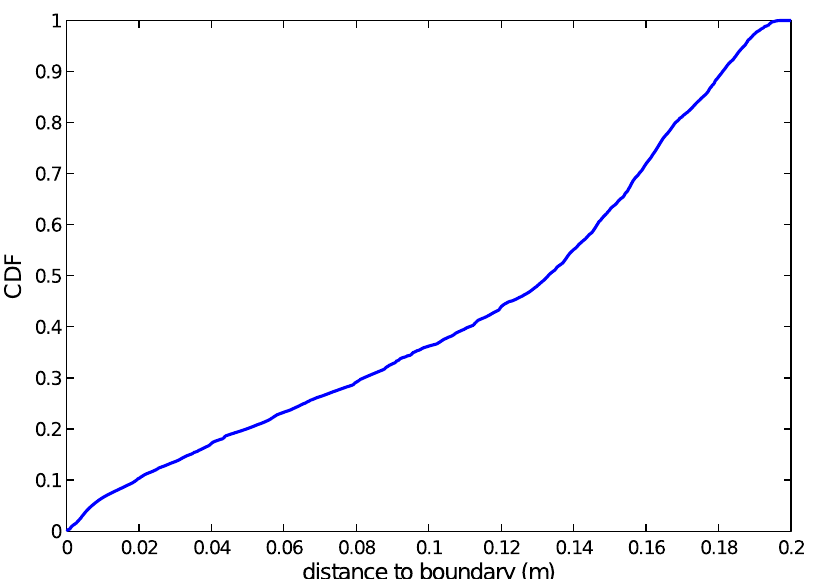
Figure 5. Cumulative distribution of aphids as a function of distance to arena boundary (in m ) for experimental data set. The circular experimental arena has a radius of 0.2 m . Only 10% of the data set corresponds to aphids within 2 cm (about five body lengths) of the boundary.